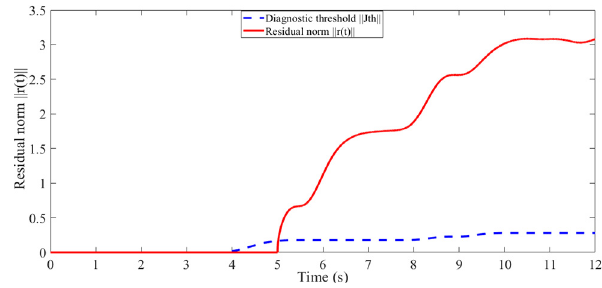
Figure 11 Results of two sensors interrupted at the same time-gain fault detection